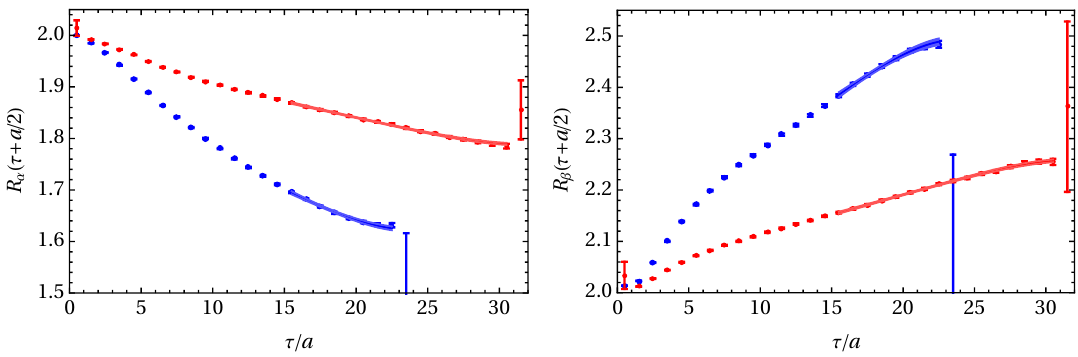
Figure 2 . Fit to the function R i ( (cid:28) + a= 2) de(cid:12)ned in eq. (5.1) for i = (cid:11) (left) and (cid:12) (right). Blue and red dots represent the data from the ensemble A40.24 and A40.32 of ref. [23], respectively. which is expected because the second term in the e(cid:11)ective range expansion, eq. (2.6), has smaller e(cid:11)ects on the discrete energy levels, as also observed in ref. [23]. As a consistency check, we also include in the same table the I = 2 threshold parameters predicted in the NLO ChPT using eq. (4.1) (with the values of physical LECs in table 2). 5 We observe a slight discrepancy between the NLO ChPT-prediction of the I = 2 scattering length